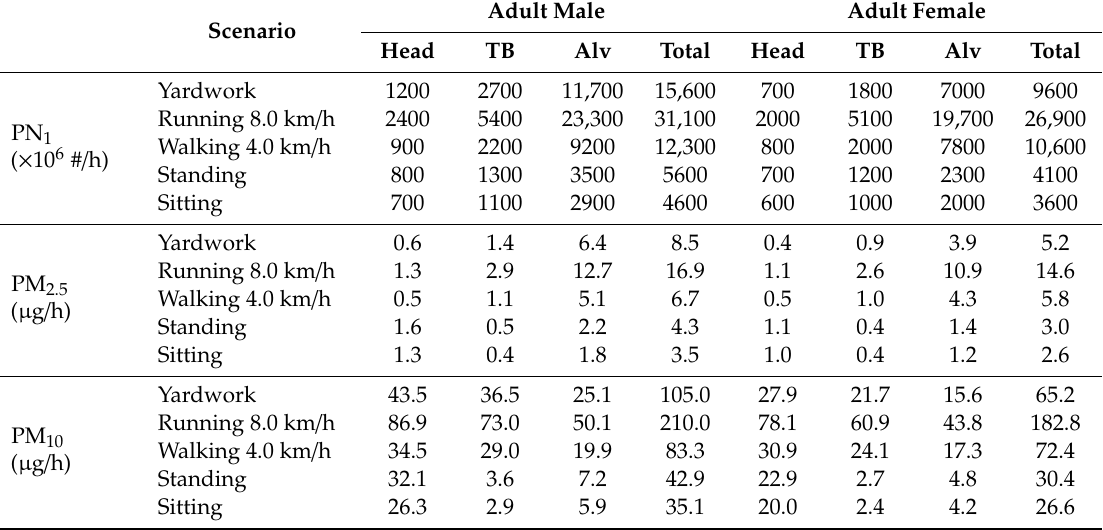
Table 5. Mean regional dose rates (head, tracheobronchial (TB), alveolar (Alv), and total) for aerosol exposure during TYPE I indoor activities. Note that yardwork is assumed to be equivalent to housework and running is equivalent to indoor